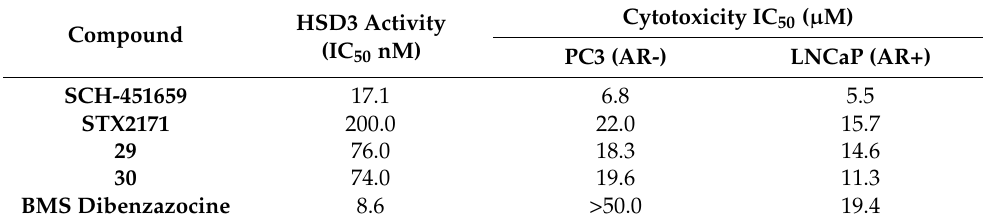
Table 11. Lack of significant androgenic and cytotoxic effects for lead